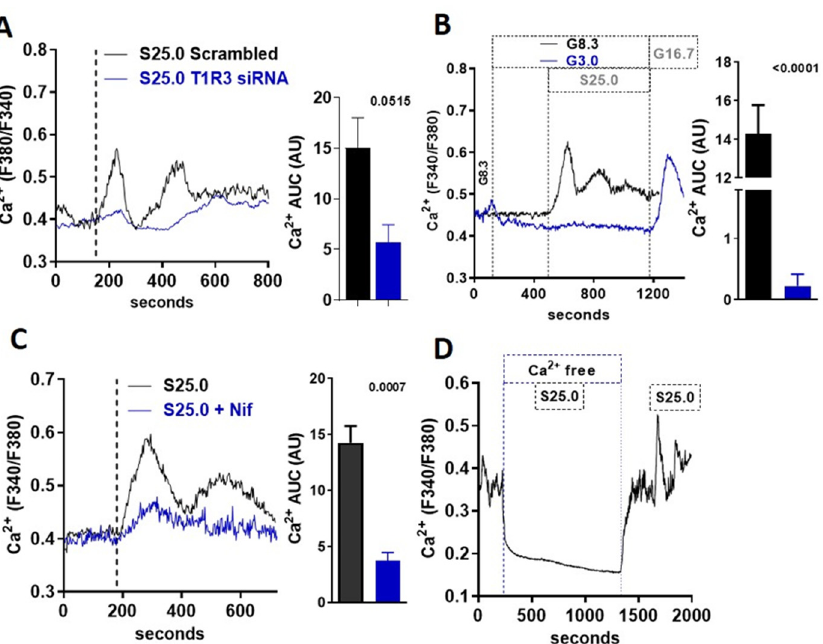
Figure 3. Saccharin-induced signaling in beta-cells is mediated by calcium influx. ( A ) Representative trace of intracellular calcium response in MIN6 beta-cells treated (vertical line) with saccharin (S; 25.0 mM + 8.3 mM glucose) with or without T1R3 knock-down. Inset: area under curve (AUC) calculated as response X time (n = 6). ( B ) Representative traces of intracellular calcium response in MIN6 beta-cells treated (vertical line) with saccharin (S; 25.0 mM) in the presence of 3.0 or 8.3 mM glucose (G). Area under curve (AUC) calculated as response X time (n = 4). ( C ) Representative traces of intracellular calcium response in MIN6 beta-cells treated (vertical line) with saccharin (S; 25 mM) and nifedipine (Nif; 1.0 mM) as shown. Inset shows area under curve (AUC) calculated as response X time. ( D ) Representative trace of intracellular calcium response in MIN6 beta-cells treated with saccharin (S; 25.0 mM) with or without extracellular calcium (Ca-free). All experiments show average traces of 20–40 cells (n = 4–6 per group). All panels show p value using two-tailed unpaired T test.